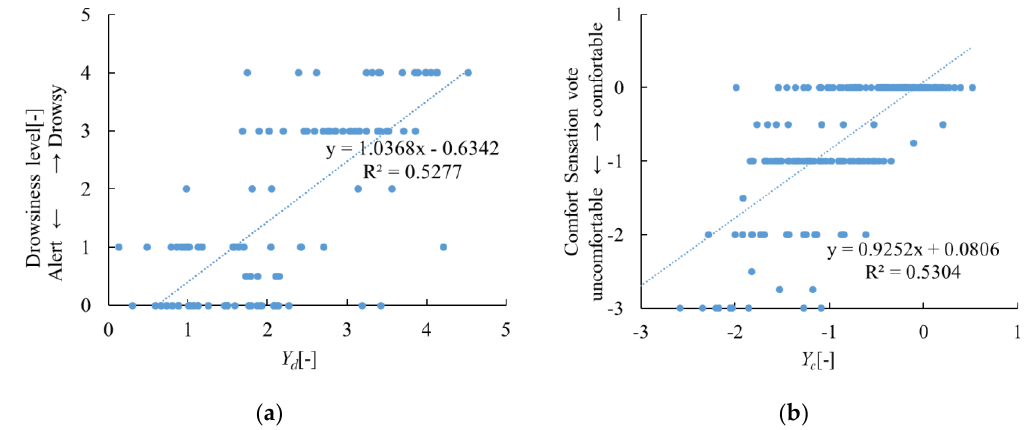
Figure 9. The relationship between the drowsiness level and Yd ( a ), the comfort sensation and Yc ( b ). (c) Review of Continuous Evaluation using Yd and Yc